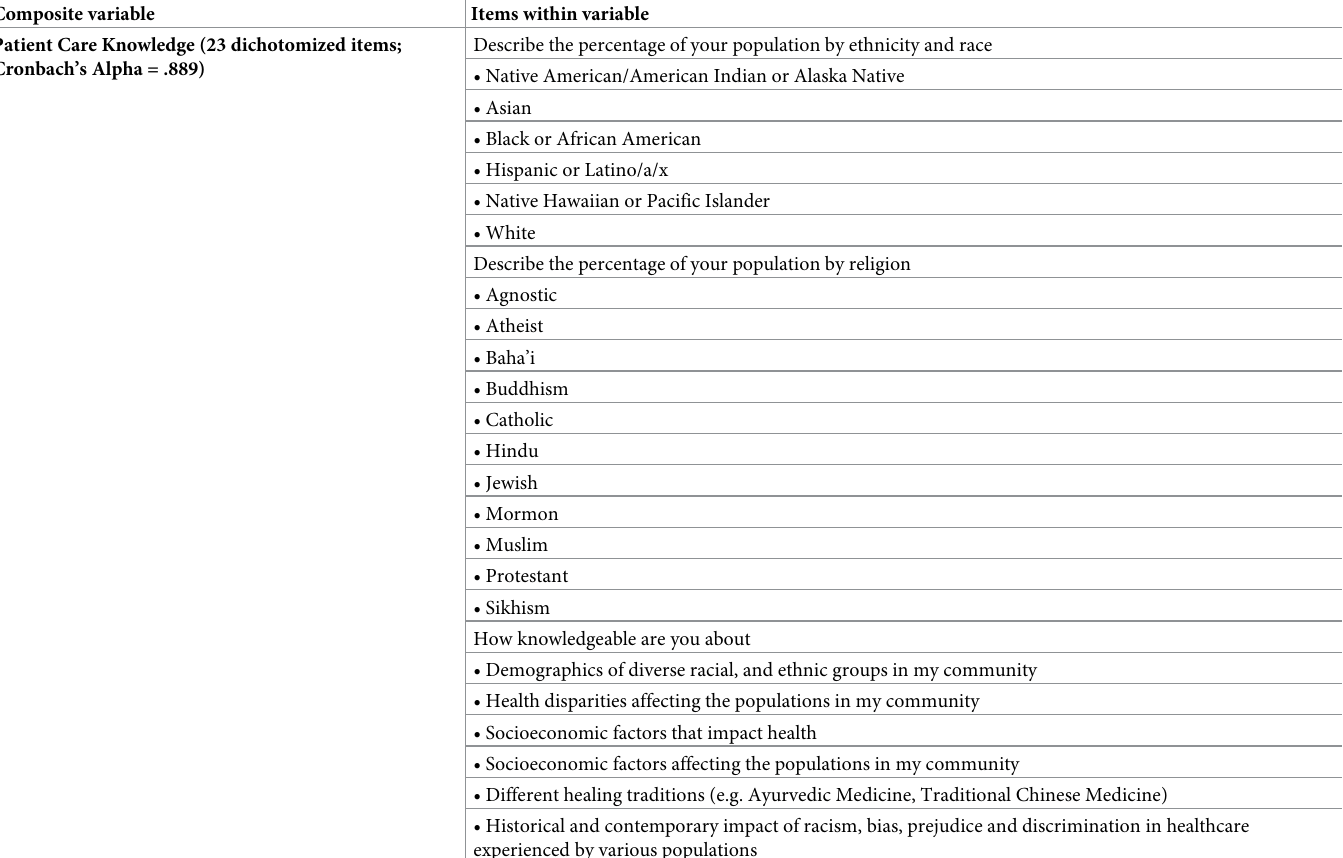
Table 1. Items for composite variables with Cronbach’s alpha score. Composite variable Items within